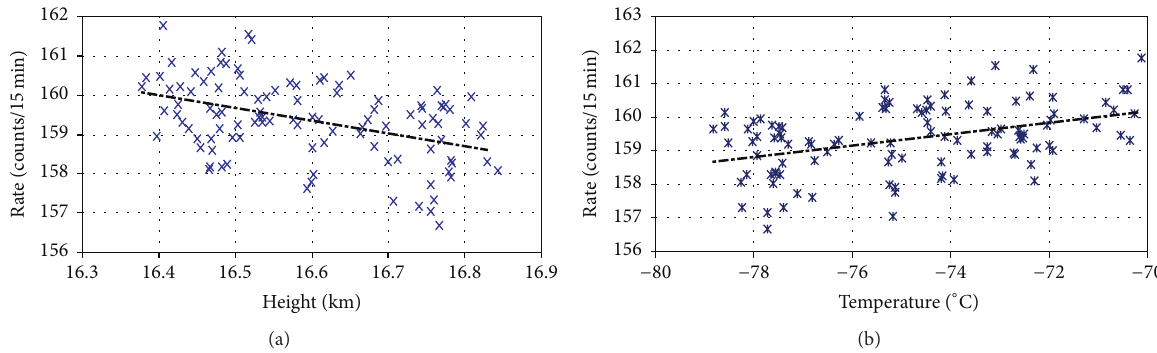
Figure 4: Scatterplot between the pressure-corrected muon rate and (a) level of pion production and (b) temperature at that level. The dashed thick lines are the regression